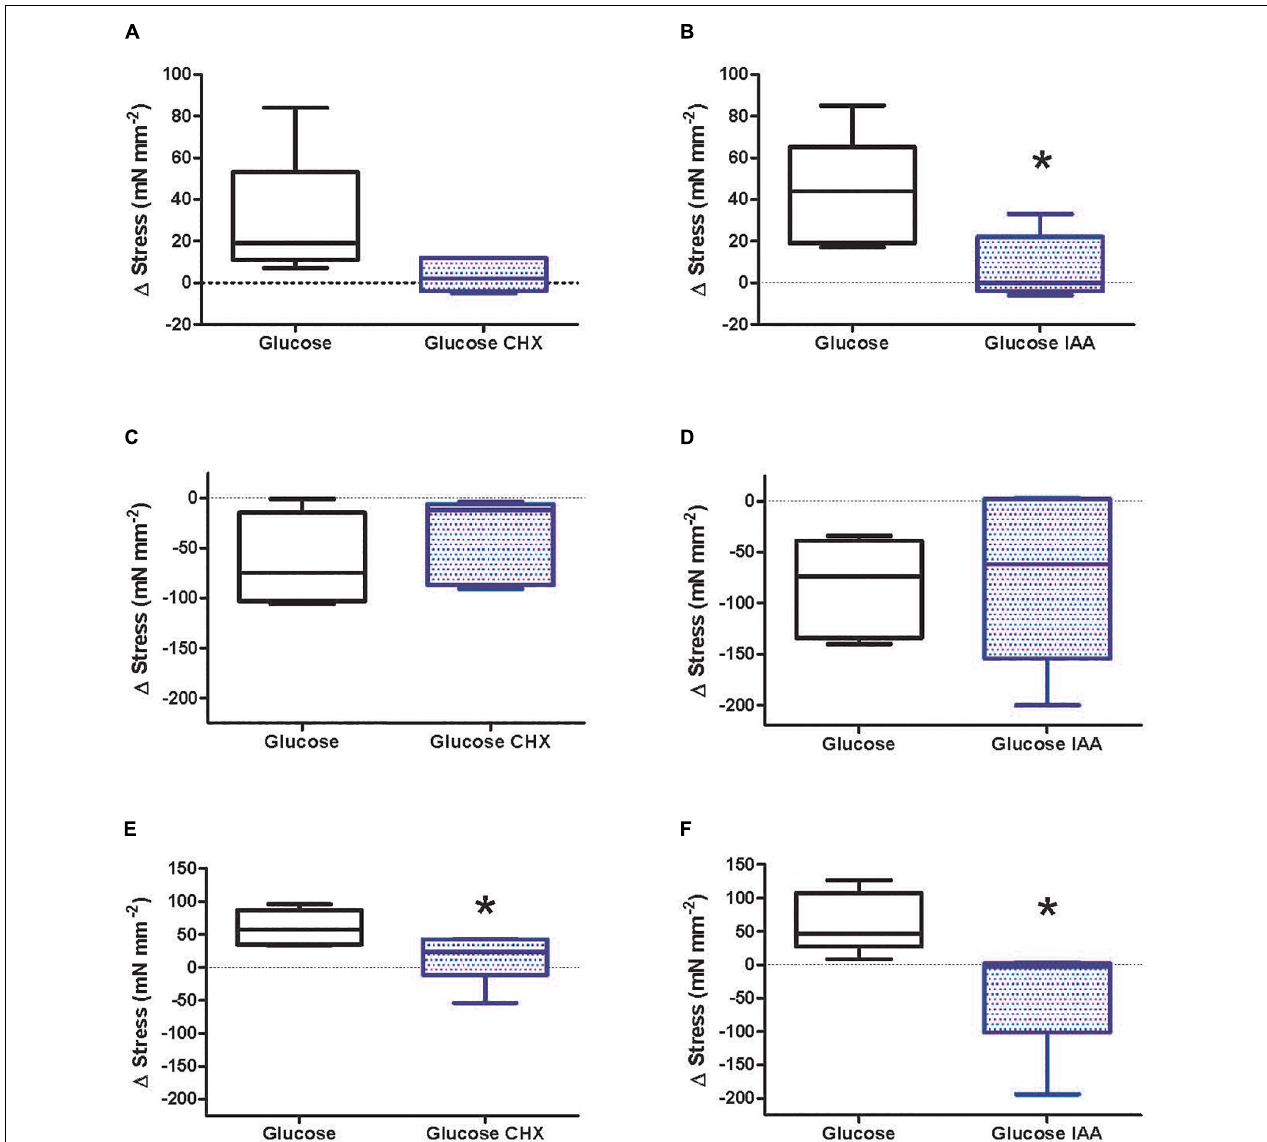
FIGURE 2 | Relative peak stress development by isometrically contracting mantle muscle strips from cuttlefish ( Sepia officinalis ). Preparations were initially stimulated to contract six times at 0.2 Hz. Stress developed during this period served as the level at which all further challenges were related. All experiments involved paired preparations. Bathing media contained glucose (open bars) plus additional 25 µ M CHX (stippled bars; left panels) or additional 1 mM IAA (stippled bars; right panels). Panels (A,B) – (cid:49) stress development following a 10 min rest followed by a second wave of six contractions at 0.2 Hz. Panels (C,D) – (cid:49) stress development following contractions for 30 s at 30 Hz [immediately following (A,B) ]. Panels (E,F) – (cid:49) stress development following 1 h rest [following (C,D) ]. ∗ Significant difference in response of matched preparation in media containing glucose alone relative to preparations in media with either additional CHX or IAA. N = 6 for CHX experiments and N = 5 for IAA experiments. Box and whisker plots show the range and median